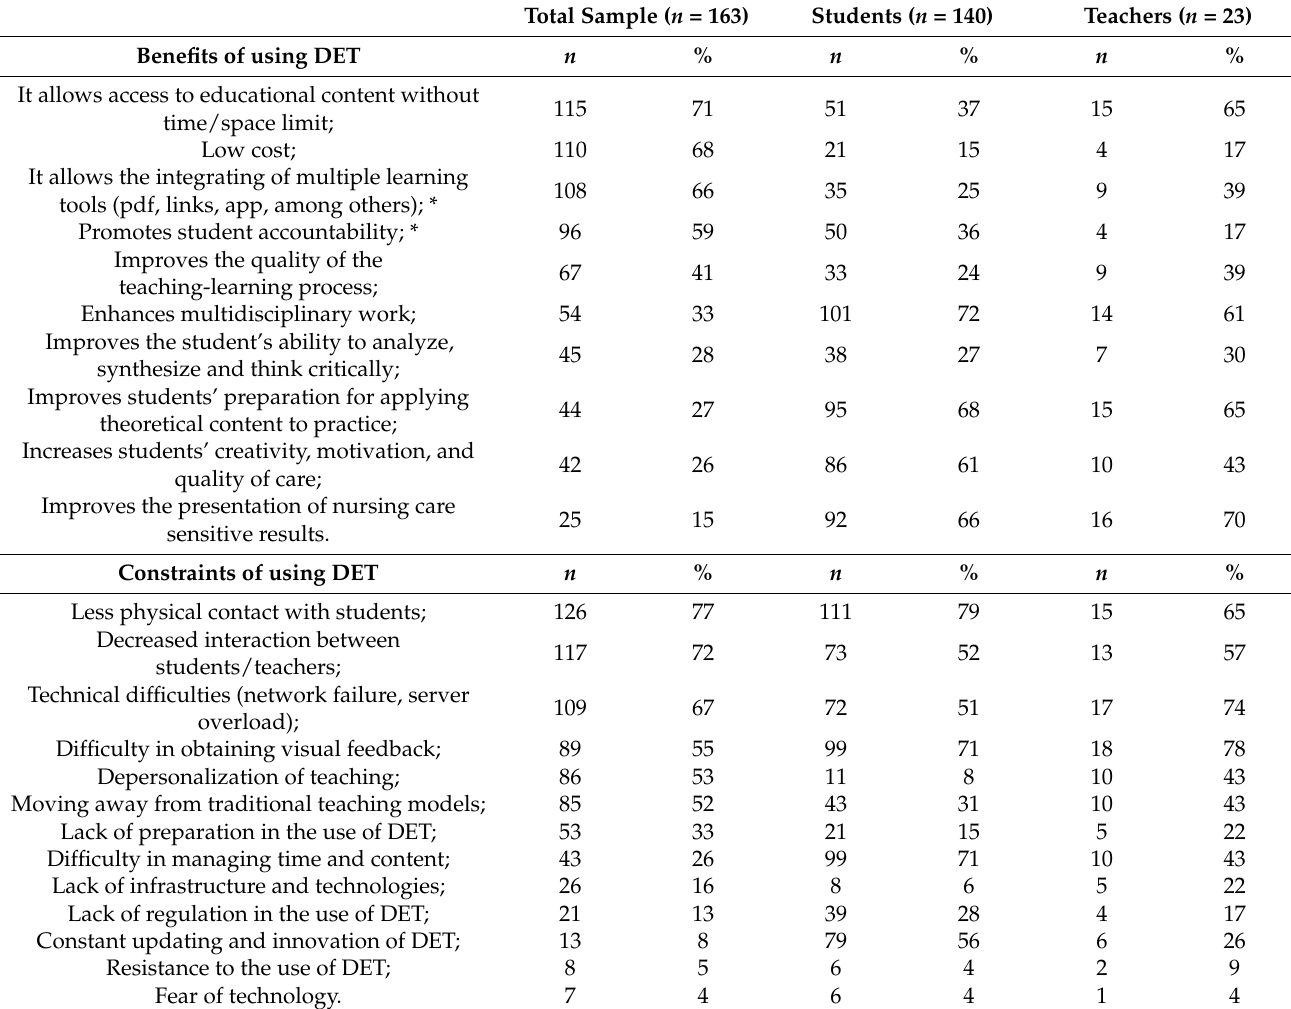
Table 4. Results regarding benefits and constraints in the use of